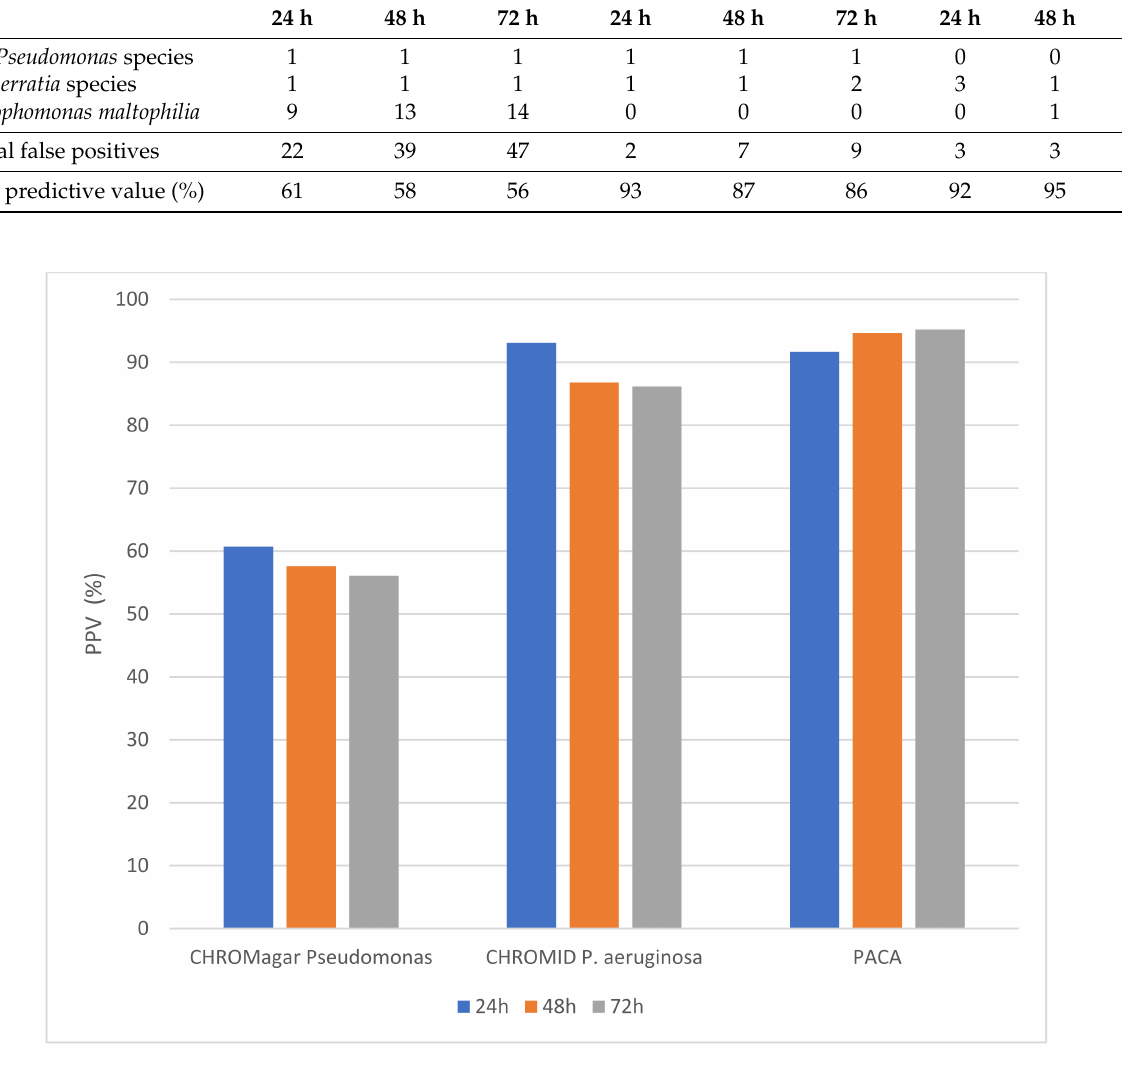
Figure 2. Positive predictive value (%) for colony color generated on three chromogenic